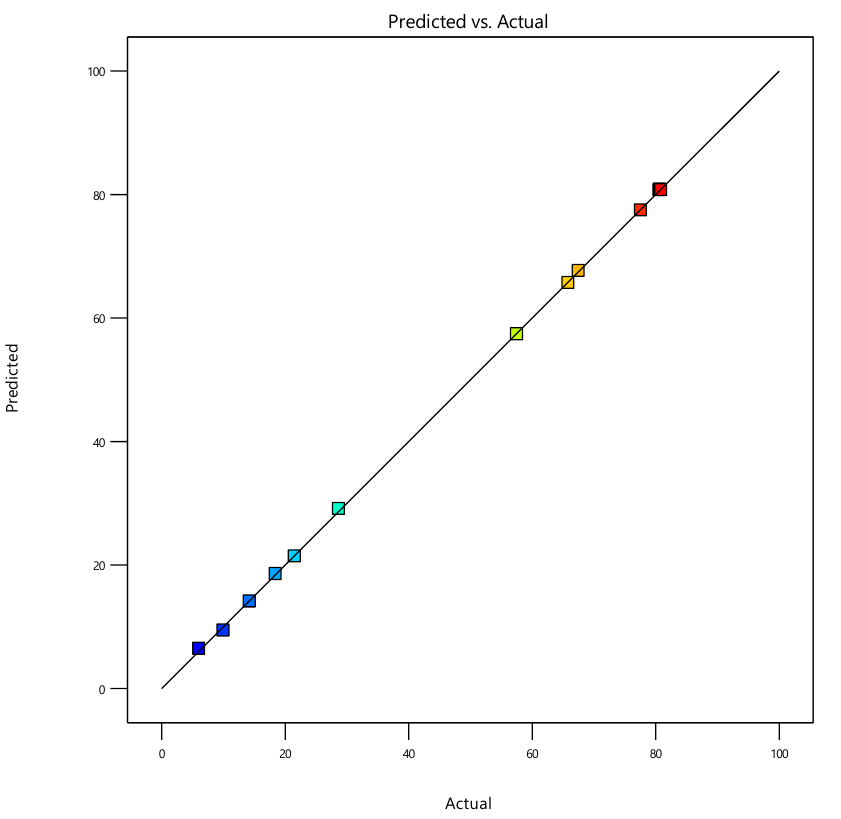
Figure 12. Predicted vs. actual measurements for R%.